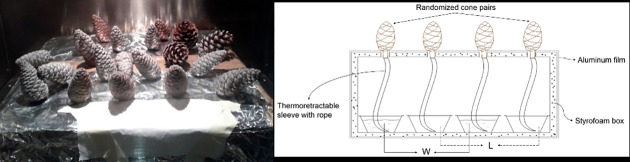
Manipulating water availability in the ex situ experiment.(A) Photograph of the styrofoam box inside the chamber. An aluminum film cover was used to further increase isolation and prevent water heating. (B) Scheme of the experiment inside the styrofoam box. W, watered cones; L, waterless cones.